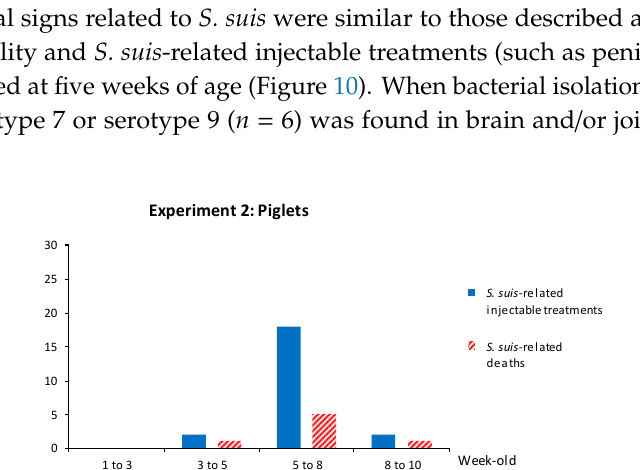
Figure 10. Experiment 2: Number of S. suis -related injectable treatments and S. suis -related deaths in piglets over time. In total, 207 piglets from vaccinated sows and 183 piglets from non-vaccinated sows were enrolled in the trial. Piglets were weaned into one nursery room, with mixed vaccinated and non-vaccinated groups in each pen. Total and S. suis -related mortality and injectable treatments were recorded from all enrolled piglets by farm staff daily by room. Pigs were identified as notched or not notched, and there were no individual pig identifiers. As such, an individual pig could be represented more than once in the dataset for treatments. Pigs were followed until the end of the nursery period.